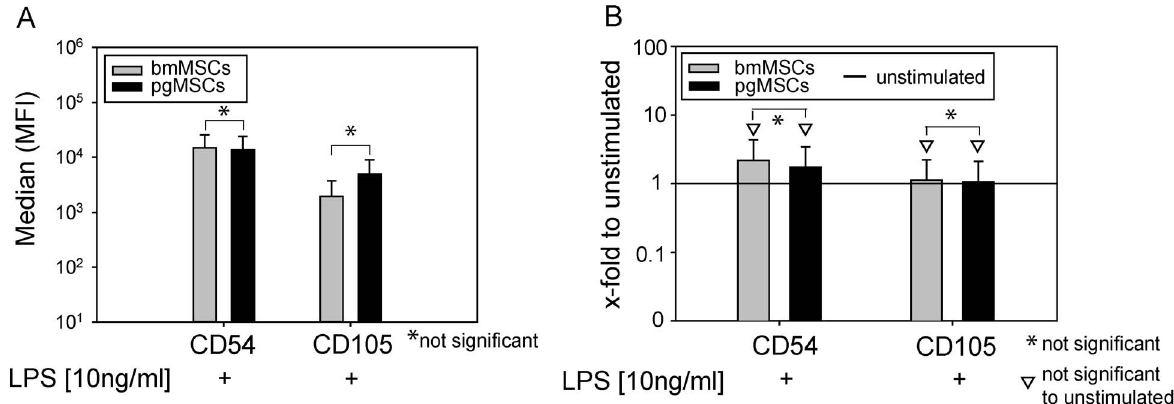
Figure 2. Expression of adhesion molecules after LPS stimulation. MSCs were left untreated or were stimulated with LPS [10 ng/ml]. Flow cytometry data are presented as D Median of 5–7 independent experiments (bmMSCs, n=5; pgMSCs, n=7). (A) Absolute fluorescence intensity is shown. (B) Relative induction of fluorescence intensity with untreated MSCs set as 1 (reference value) is shown for visualization of LPS-induced up- regulation; Mann-Whitney U test was used for statistical analysis; significance was set at the level of P # 0.05.